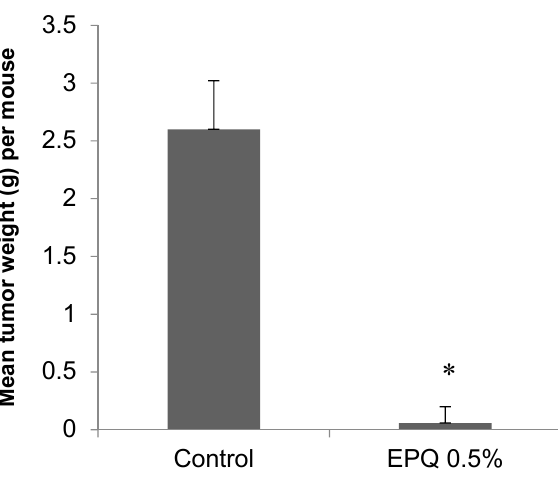
Figure 1. Effect of 0.5% EPQ dietary supplementation on mean weight of A-2780 ovarian tumors in female nude mice injected with 2 × 10 6 A-2780 cells (* indicates significance of p < 0.0001 with respect to control).